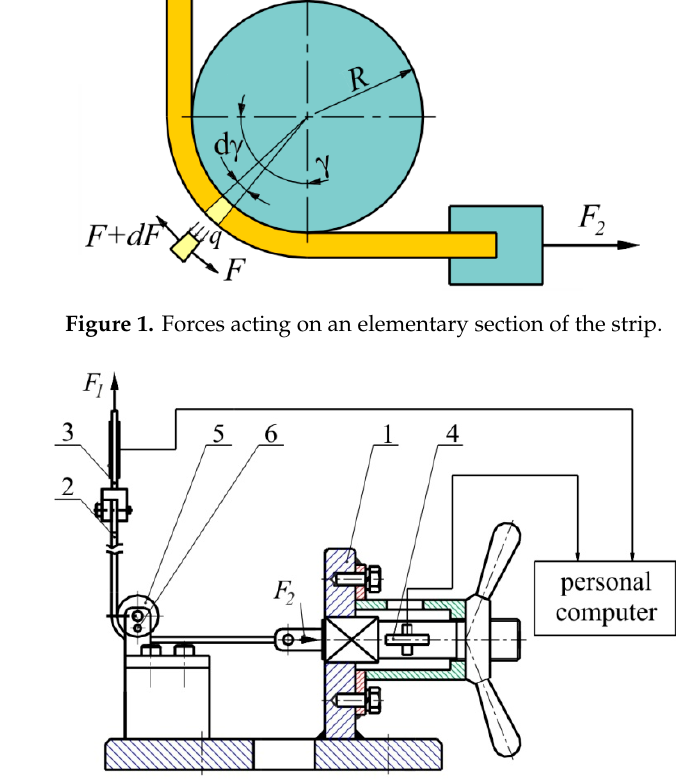
Figure 2. Schematic diagram of the measuring device for bending under tension (BUT): 1—Frame; 2—Specimen; 3—Vertical load cell; 4—Horizontal load cell; 5—Working roller; 6—Blocked pin.